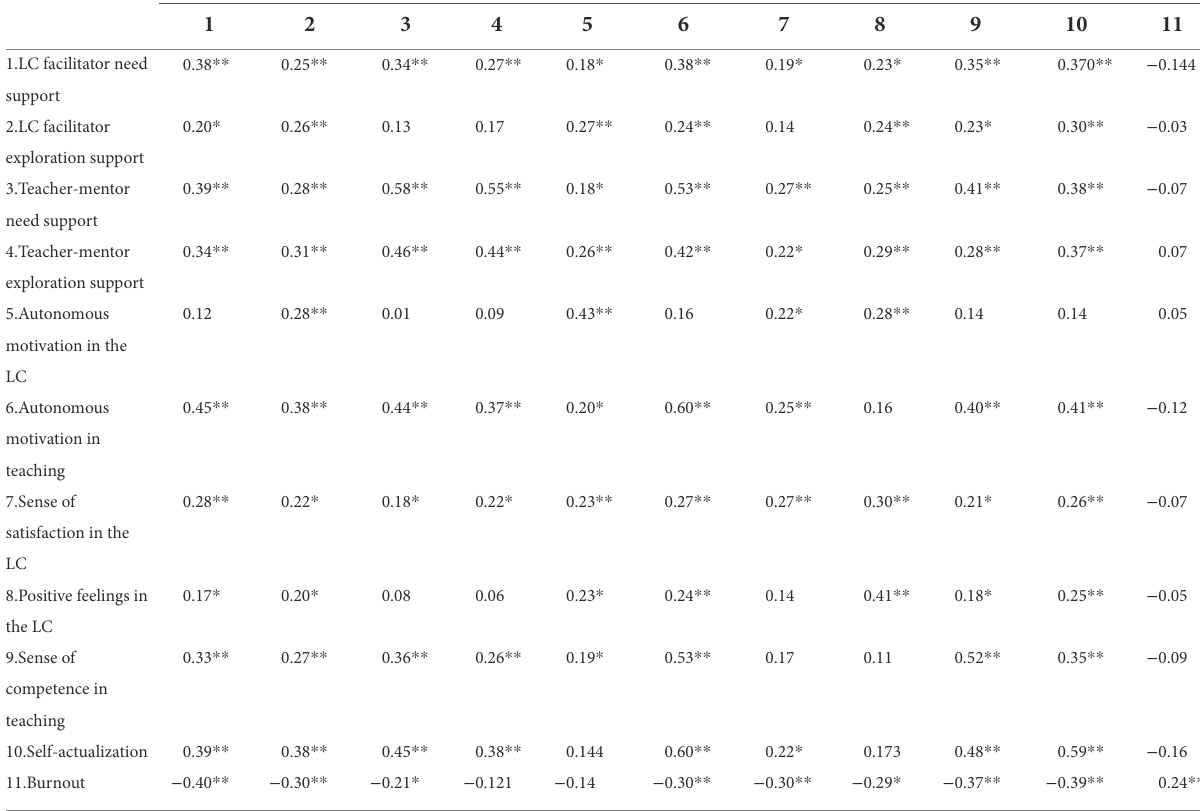
TABLE 4 Correlations between the research variables at T1 and